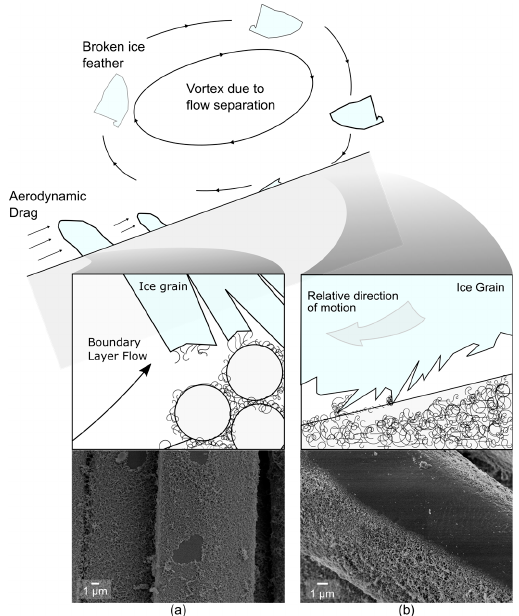
Figure 9. Sketch of two envisioned damage mechanisms of the flat plate configuration. ( a ) One being the tearing of an isolated feather ice grain from the fabric surface due to aerodynamic drag. ( b ) The second being after breakage of the feathery ice grain, it being carried, by a separated backflow of air, away from the surface and then back towards it, causing erosive or scratching damage to surface nanofilaments. The insets are SEM images of either pulling or erosive damage that was observed from experiments.